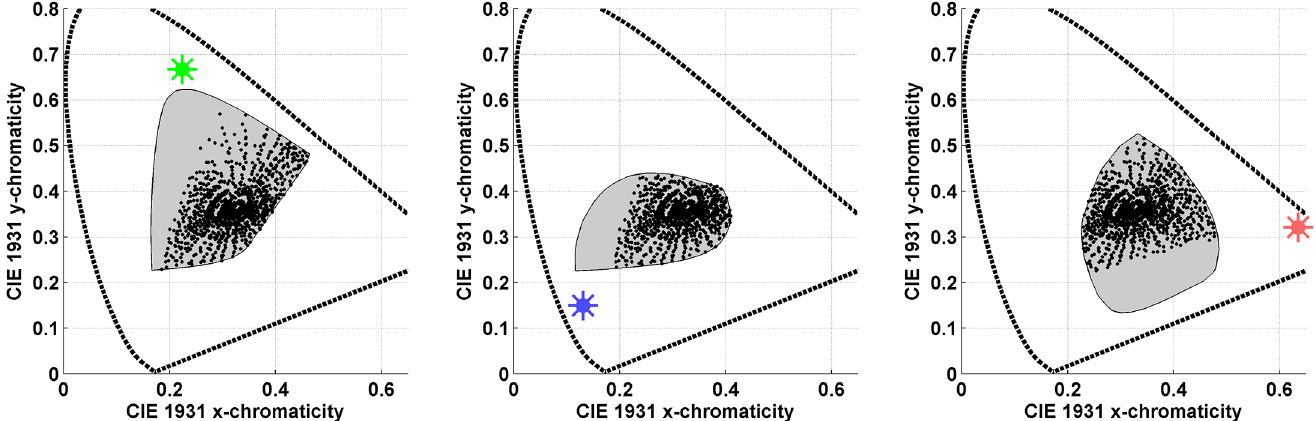
Fig 10. Chromaticity mismatch areas for several illumination conditions. Chromaticity mismatch areas (grey regions) for the following illumination conditions: (Left) green (G) to neutral (N); (Centre) blue (B) to neutral (N); and (Right) red (R) to neutral (N). The green, blue and red asterisks indicate the chromaticity of the flat grey reflectance under the G, B and R illuminants respectively. The black markers are the chromaticities under neutral illumination (N) of the numerous Munsell papers that fall inside each of the metamer mismatch areas.